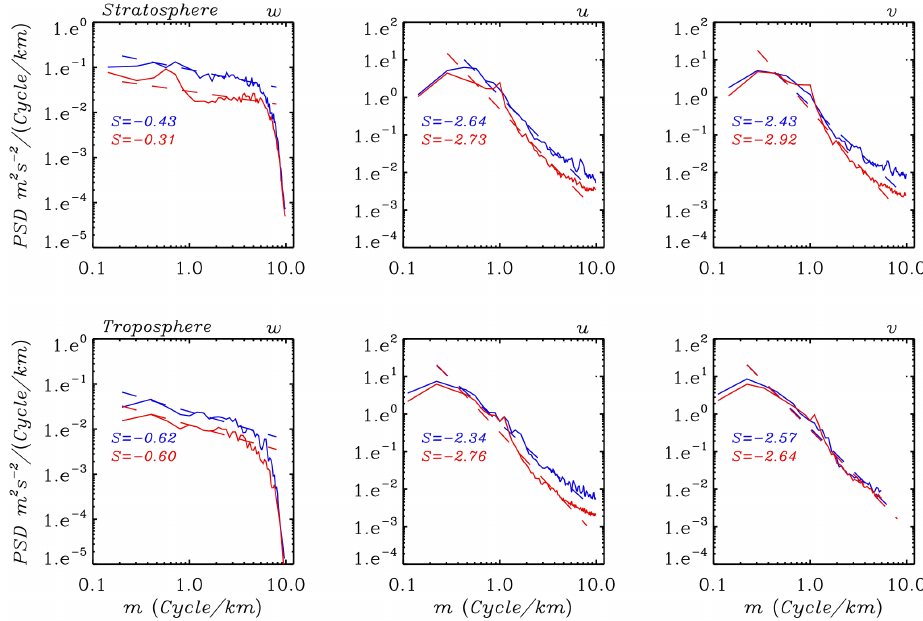
Figure 2. Monthly averaged vertical wavenumber spectra of the vertical (left panel), zonal (middle panel), and meridional (right panel) wind fluctuations in logarithm coordinates at Miramar NAS (32.87 ◦ N, 117.15 ◦ W), CA. The bottom and upper panels denote, respectively, the spectra in the tropospheric and lower-stratospheric regions. The spectra in a winter month (January 1998) and a summer month (July 2003) are plotted in blue and red curves, respectively. The dashed lines represent the linear fitting, and the corresponding fitted slopes are also marked.